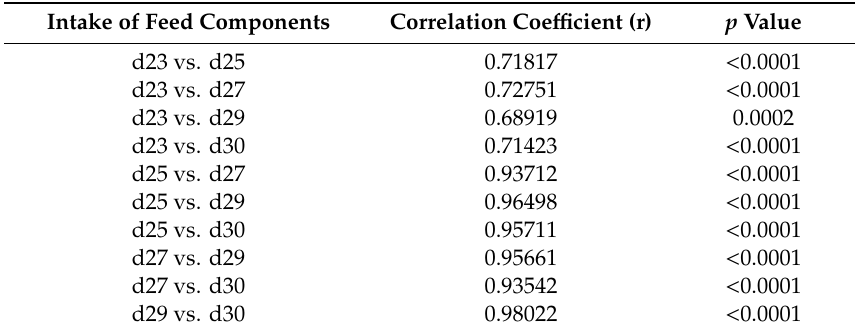
Table 6. Pearson’s correlation coe ffi cient and p -value of feed intake of all ingredients between the ages of the birds at 23, 25, 27, 29, and 30 days of